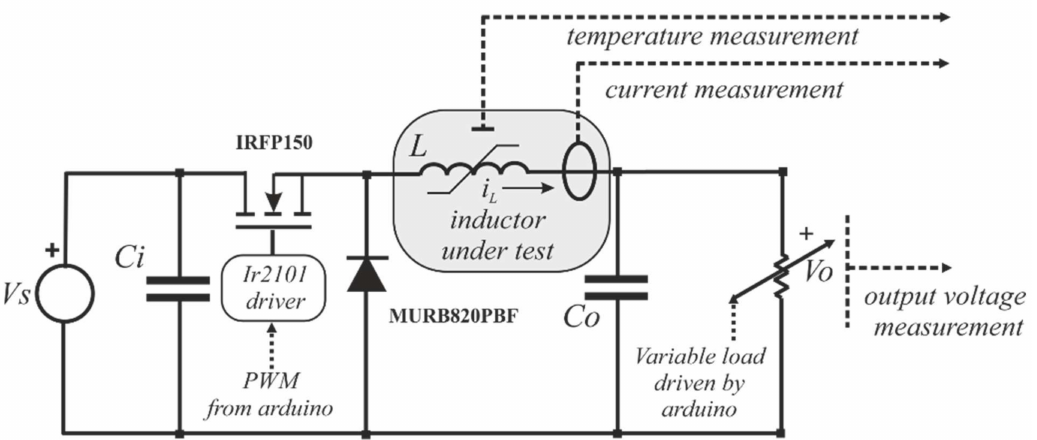
Figure 2. Simplified circuit schematic of the DC/DC buck